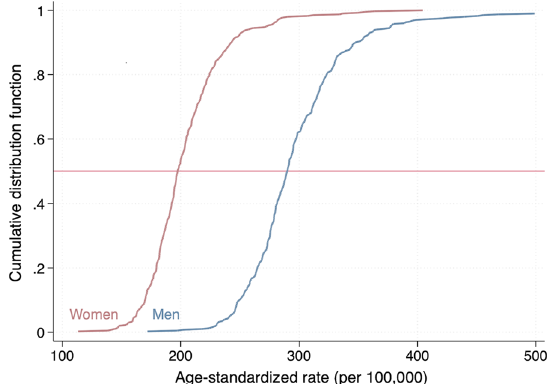
Fig. 3 Cumulative distribution function of age-standardized stroke rates by